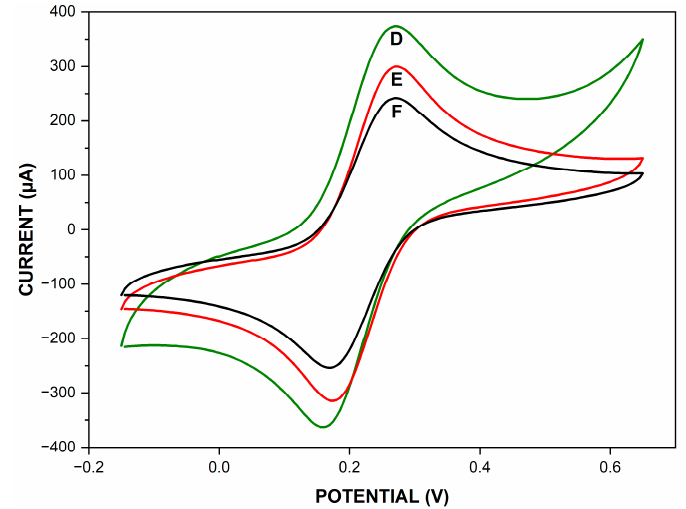
Figure 3. Cyclic voltammograms of CysAm/AuNPs/CB/PGE (D), BSA/ssDNA/CysAm/AuNPs/CB/PGE (E), and miRNA-21/BSA/ssDNA/CysAm/AuNPs/CB/PGE (F) recorded in 5 mM [Fe(CN) 6 ] 3 − /4 − containing 0.1 M KCl.